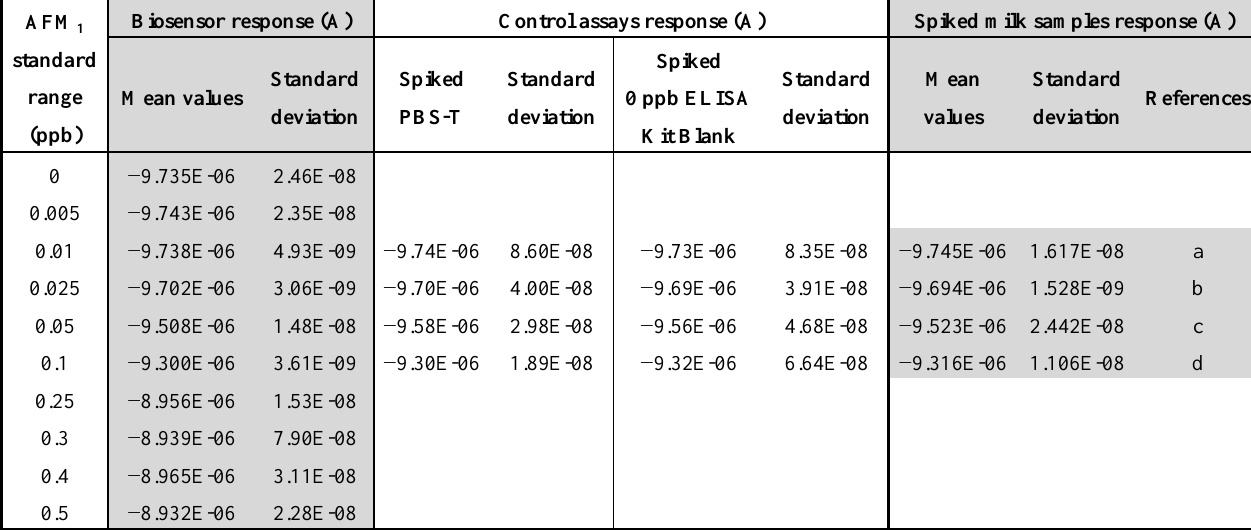
standard range (blue squares) and the spiked AFM 1